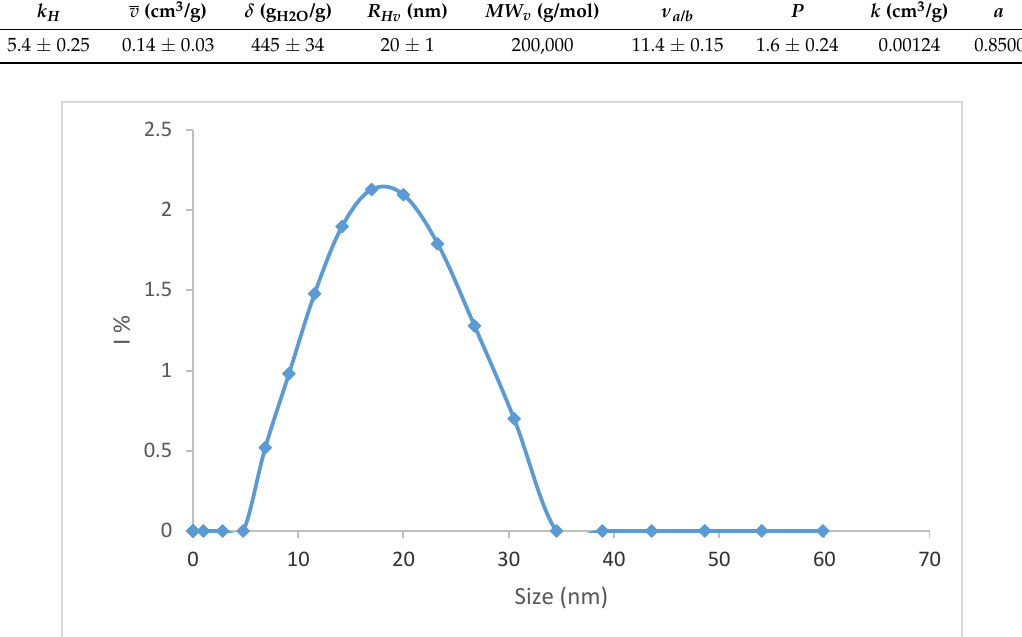
Table 2. Mark–Houwink and hydrodynamic parameters.